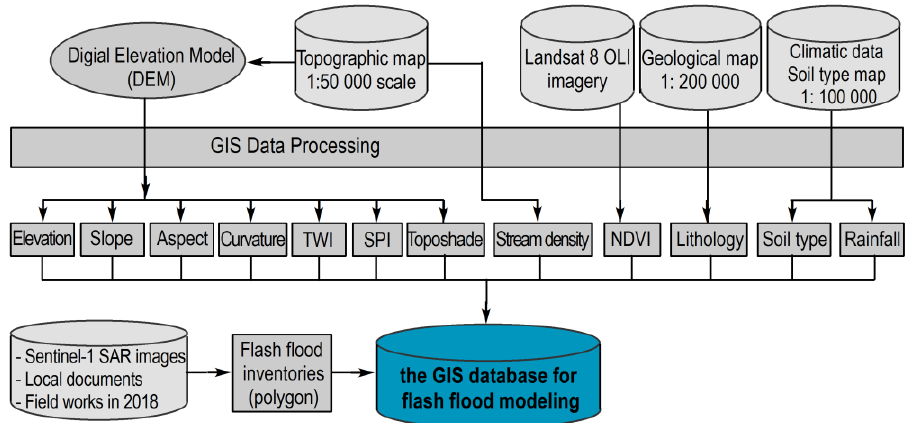
Figure 6. The established GIS database for the flash-flood modeling.